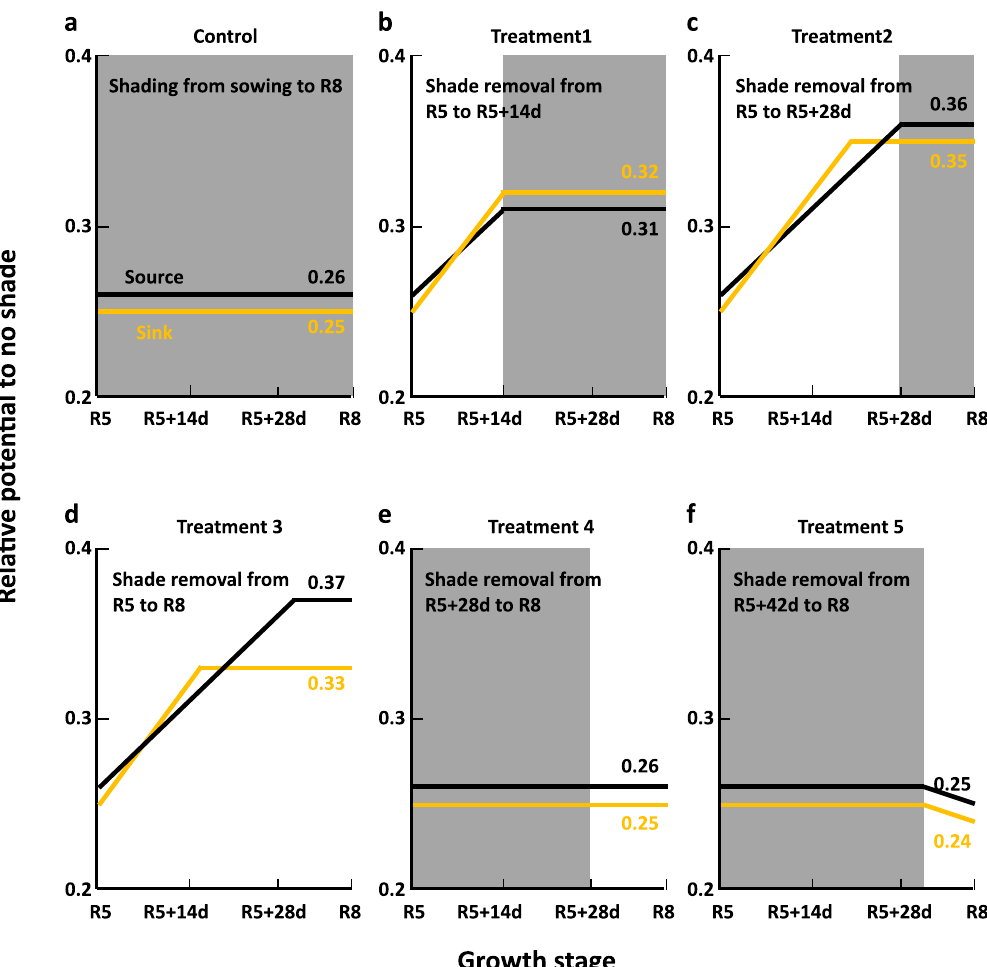
Figure 4. Schematic diagram of relative sink and source potentials to no shade treatment after the R5 growth stage. Control ( a ), treatment 1 ( b ), treatment 2 ( c ), treatment 3 ( d ), treatment 4 ( e ), and treatment 5 ( f ) of Experiment 2. Relative sink potential to no shade was estimated by seed number per plant relative to that of the no shade treatment (treatment 6) at the R8 growth stage (Tables 1, 3). Relative source potential to no shade was estimated by the seed weight, dry weights of pod and stem per plant relative to that of the no shade treatment at the R8 growth stage (Tables 1, 3). In this model, the relative potentials are supposed to be unchanged under shading. The sink potential is increased by shade removal until around R5 + 14d, while the source potential is increased by shade removal until around R5 + 28 d. Shade removal after R5 + 28 d has no or negative effect. The increasing rate of relative potentials under shade removal is supposed to be same between treatments. Gray area indicates the period covered with a shade